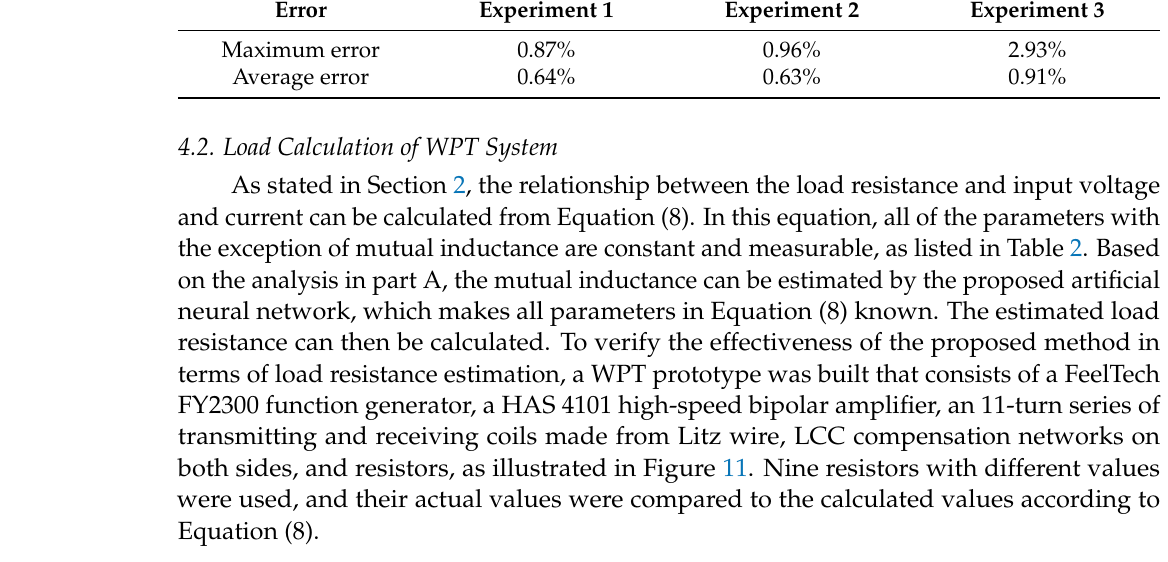
Table 2. System parameters of the WPT